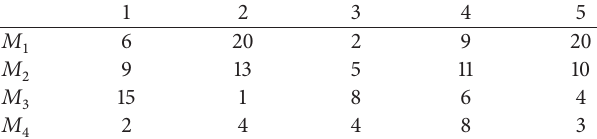
Table 6: Data of 5-job-4-machine instance of Example 3.